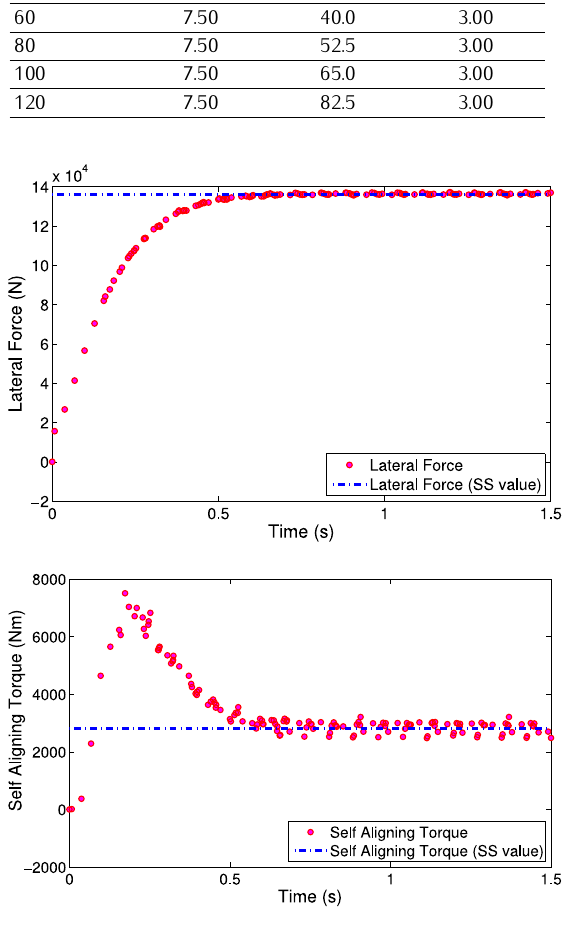
Figure 17. Lateral Force and Self Aligning Torque in